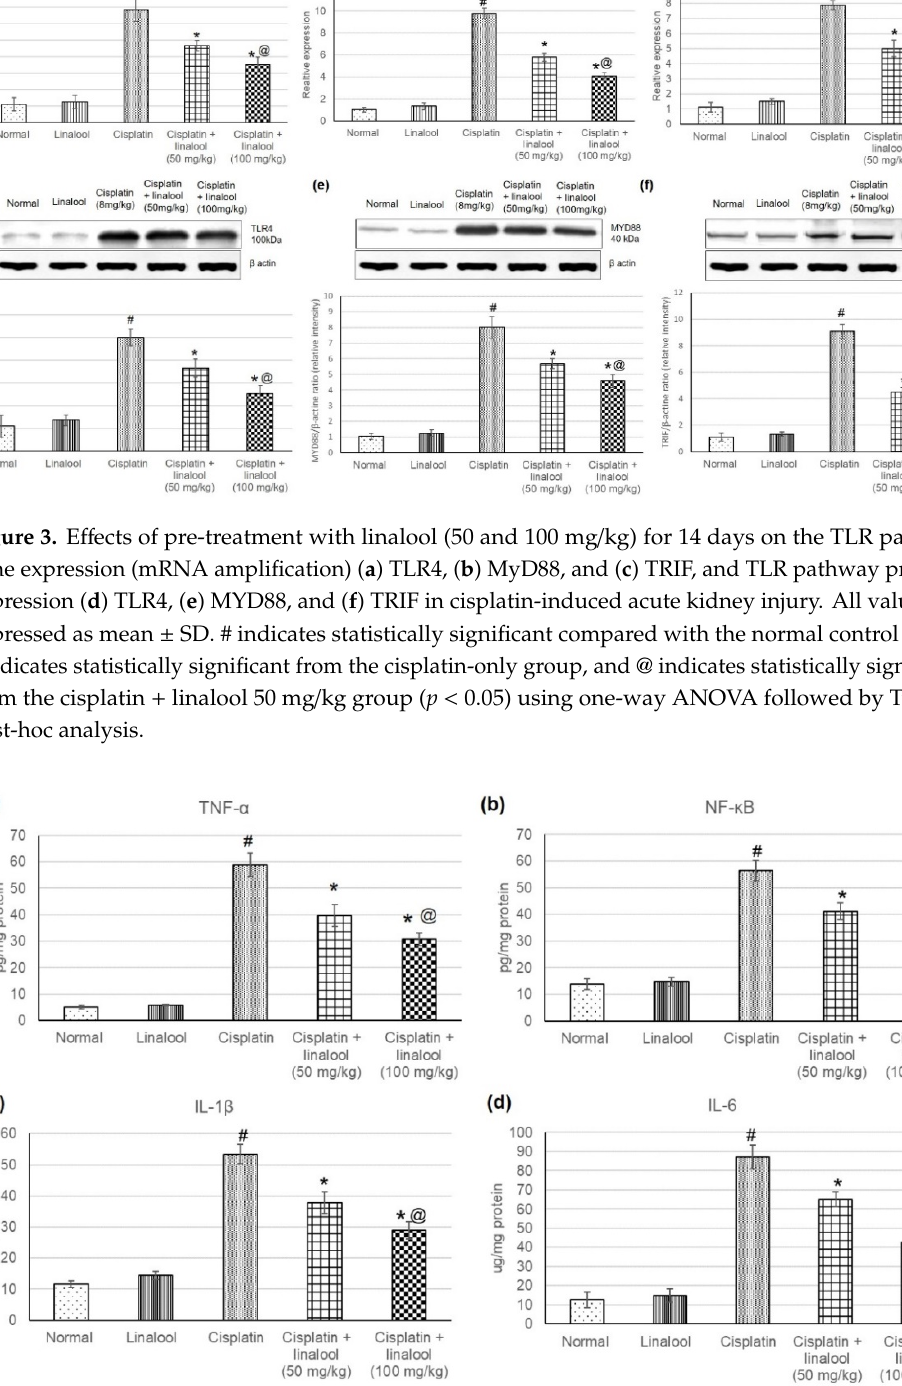
Figure 4. E ff ects of pre-treatment with linalool (50 and 100 mg / kg) for 14 days on the inflammatory mediators ( a ) TNF- α , ( b ) NF- κ B, ( c ) IL-1 β , and ( d ) IL-6 in cisplatin-induced acute kidney injury. All values are expressed as mean ± SD. # indicates statistically significant from normal control group, * indicates statistically significant from cisplatin-only group, and @ indicates statistically significant from cisplatin + linalool 50 mg / kg group ( p < 0.05) using one-way ANOVA followed by Tukey’s post-hoc